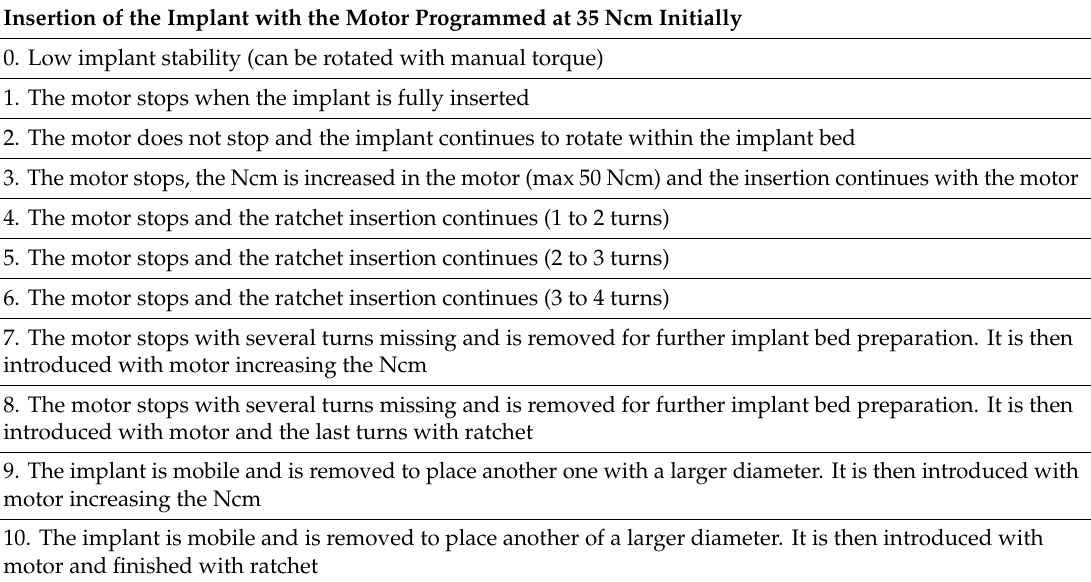
Table 5. Implant torque at the time of